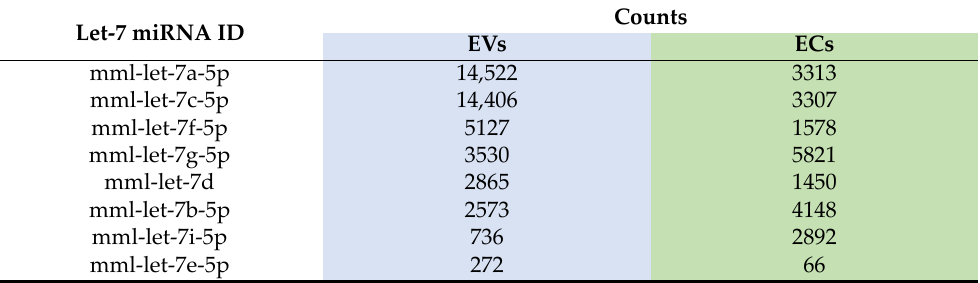
Table 2. Top 10 most highly enriched miRNA by counts in EVs and ECs from pre‑infection plasma